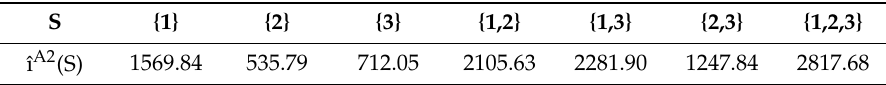
Table 24. Investment cost game plus IDC costs are calculated as î A2 = 1.065 ˆ c A2 , where c A2 are the costs reported in Table 8.